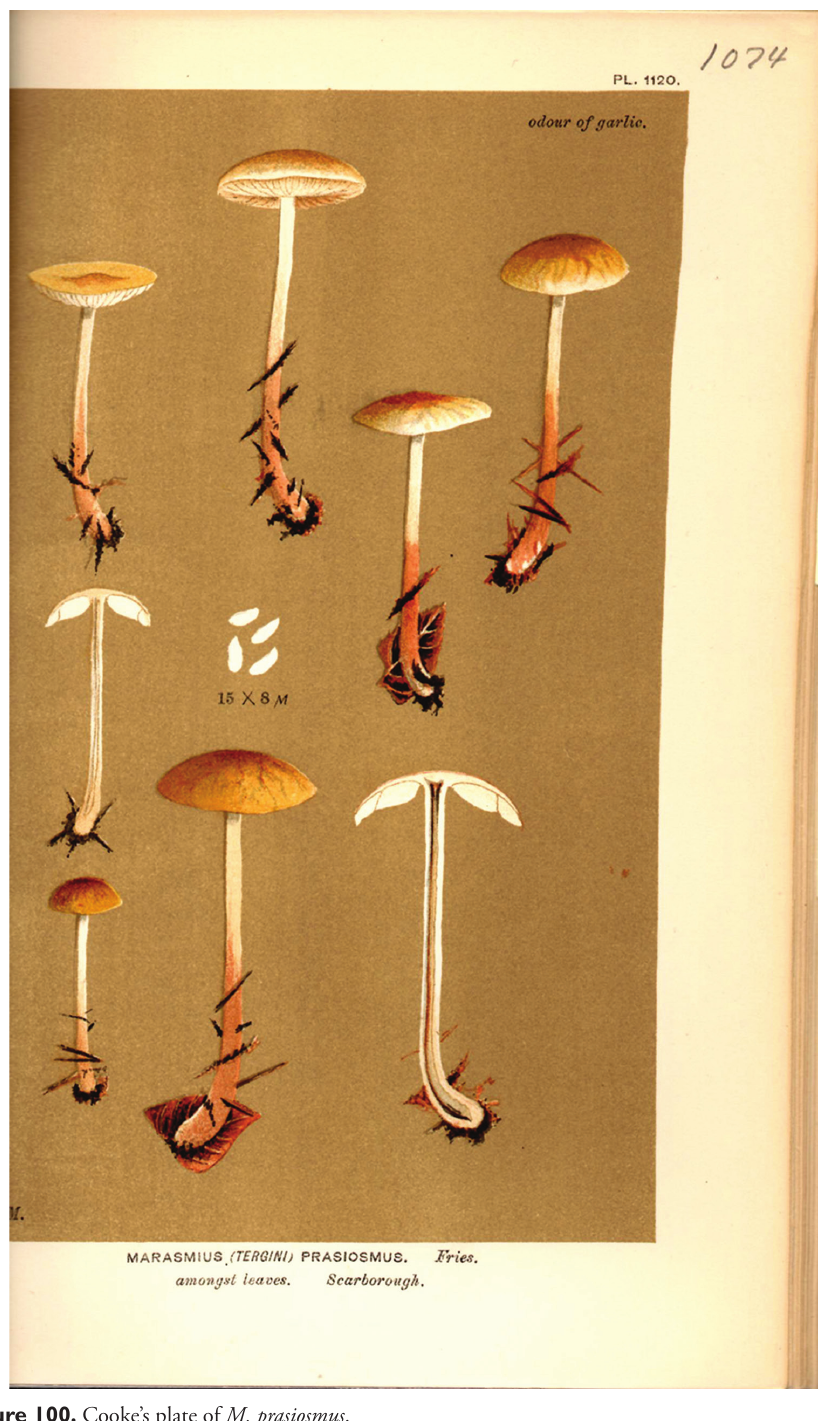
Figure 100. Cooke’s plate of M. prasiosmus